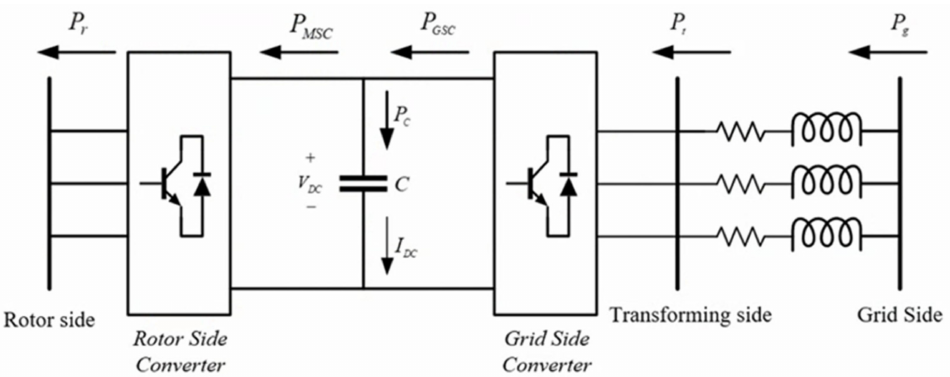
Figure 7. DFIG Grid-Connected System.